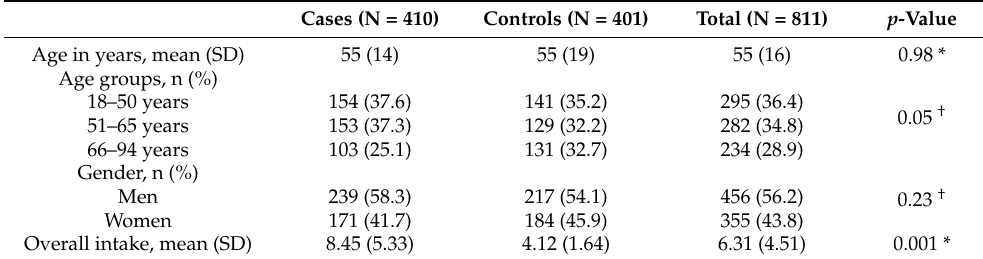
Table 1. Participant characteristics and overall intake of plant-based foods.